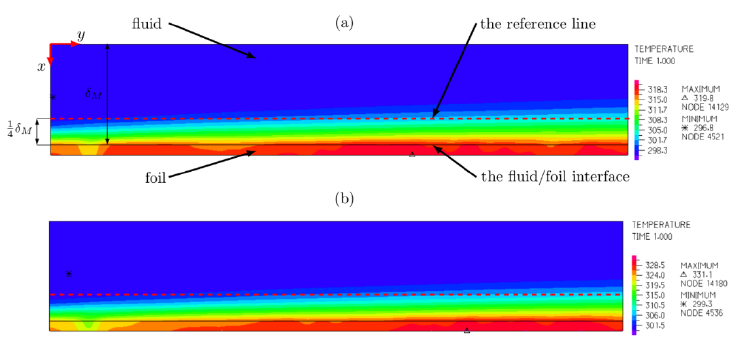
Figure 9. Temperature vs. the distance from the minichannel inlet at the fluid/foil interface obtained from 2D computations using the Trefftz functions (green line), ADINA software (red line), according to the 1D approach (blue line) and T F,IR ( y )—the data from experimental measurements on the outer foil surface due to infrared thermography (black line); the test section with five minichannels; experimental parameters listed in Table 2, heat flux values: ( a ) q’’ = 13.8 kW/m 2 ; ( b ) q’’ = 24.6 kW/m 2 ;